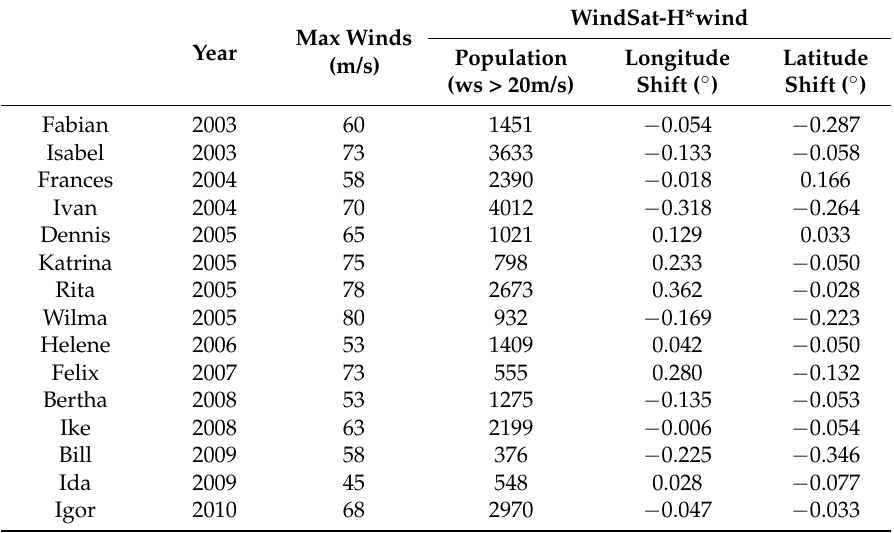
Table 1. Statistics of matchups between WindSat observations and H*wind analysis data for each selected